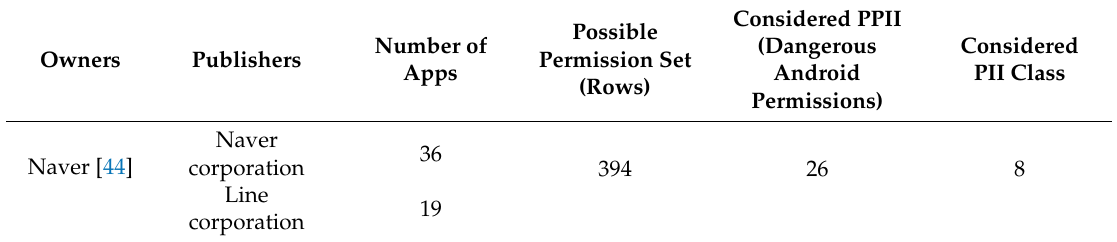
Table 8. Numerical overview of the dataset used for the Naver case